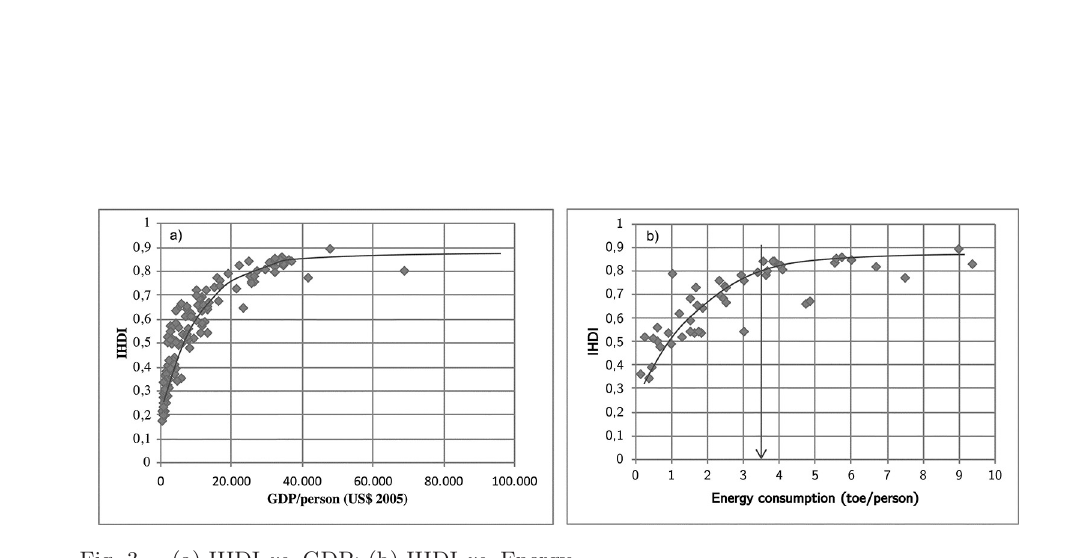
Fig. 3. – (a) IHDI vs. GDP; (b) IHDI vs. Energy.